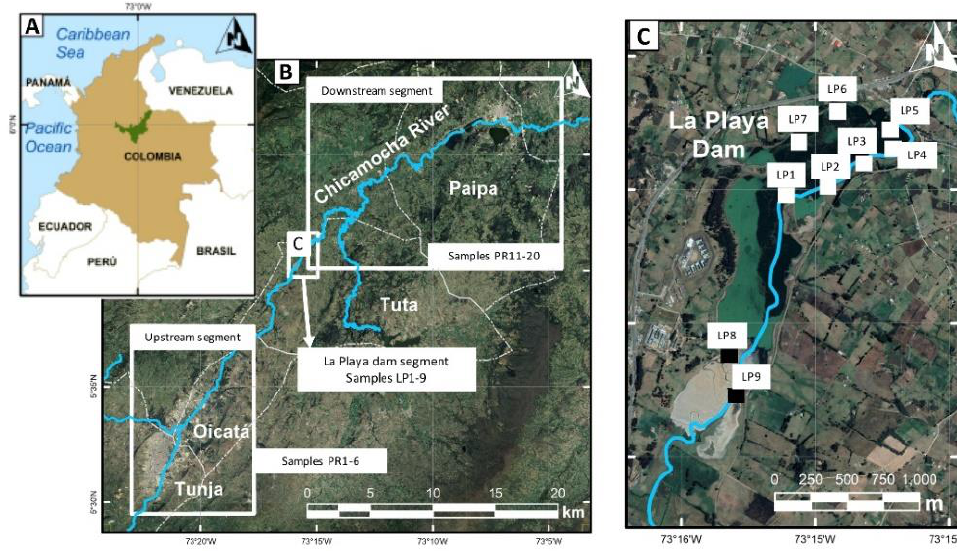
Figure 1. Study area and location of samples: ( A ) global map of the region; ( B ) studied segments from the Chicamocha River; ( C ) detail of the La Playa segment.